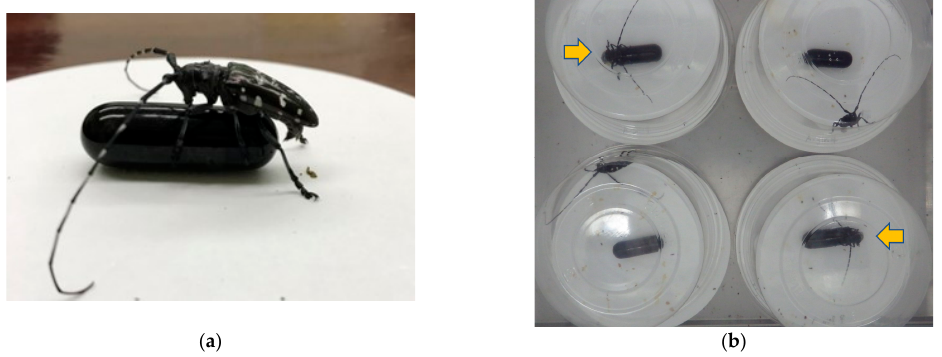
Figure 1. Anoplophora glabripennis males. ( a ) A male persistently held and bent his abdomen toward a glass model that was coated with conspecific female extract (Bioassay 1); and ( b ) males with glass models that were coated with the female extract. Two of them (yellow arrows) persistently held and bent their abdomens toward the models (Bioassay 2).